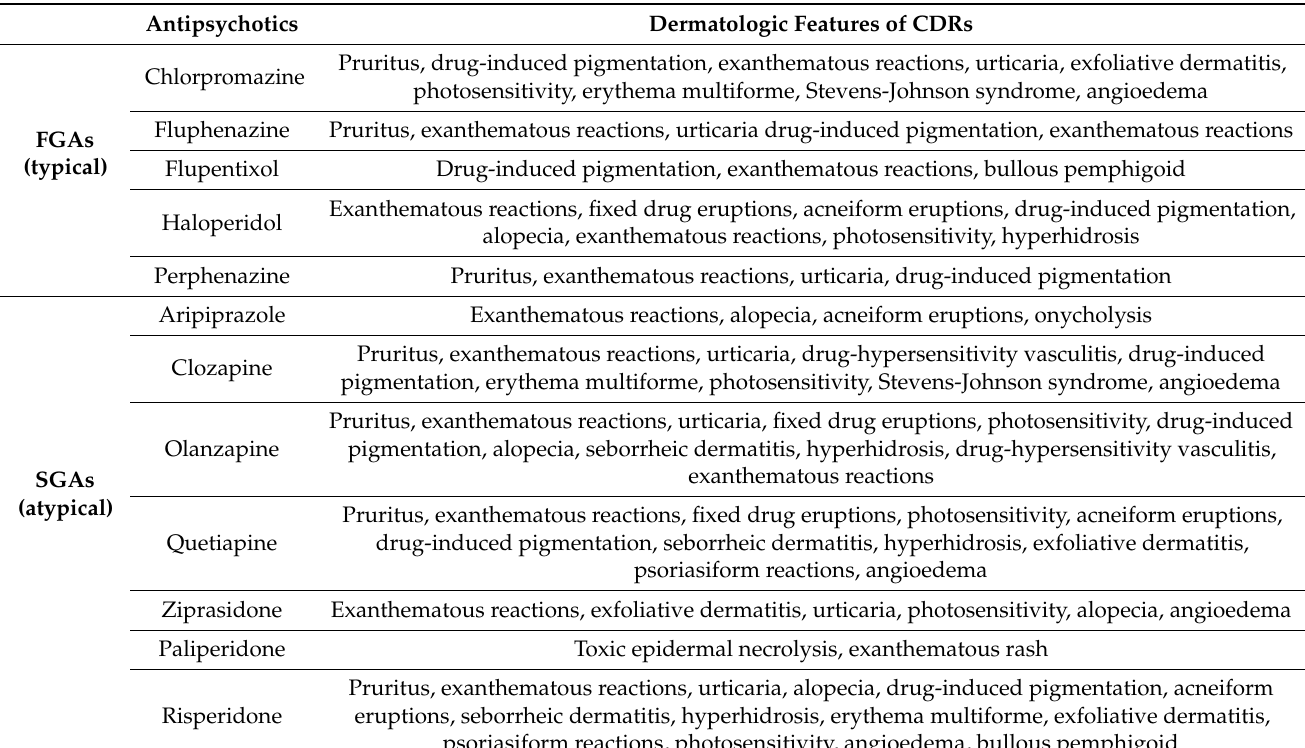
Table 1. Cutaneous drug reactions (CDRs) associated with the use of first-generation antipsychotics (FGAs), known as typical, and second-generation antipsychotics (SGAs), known as atypical. Antipsychotics Dermatologic Features of